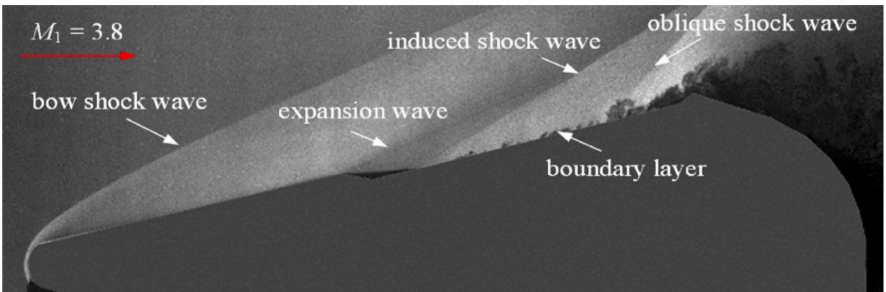
Figure 10. Experimental result of hypersonic turbulent flow field over the optical window